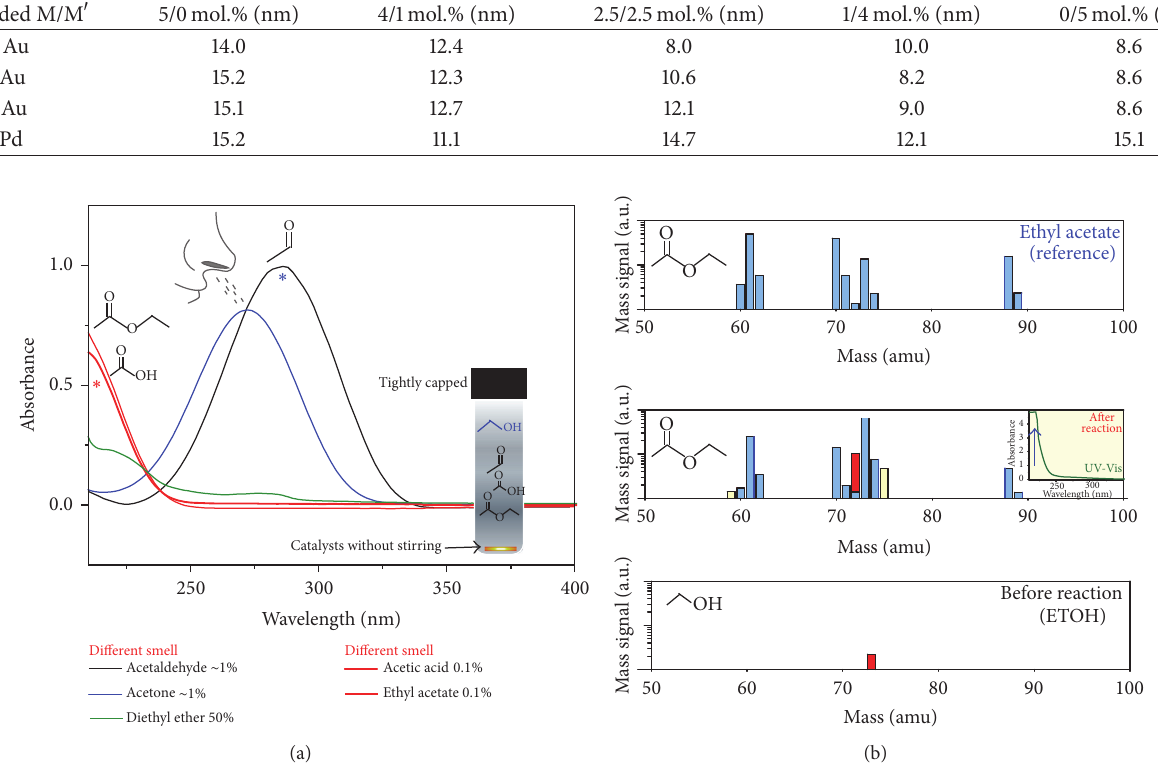
Figure 8: UV-Vis absorption spectra (a) of standard samples of acetaldehyde (1%), acetone (1%), acetic acid (0.1%), and ethyl acetate (0.1%). Massspectra(b)ofreferencesamples(ethylacetateandethanol)andthesolutionsampleafterreaction.TheinsetshowstheUV-Visabsorption spectrum of the corresponding sample solution. Blue and red ∗ indicate the peak positions for acetaldehyde and ethyl acetate,